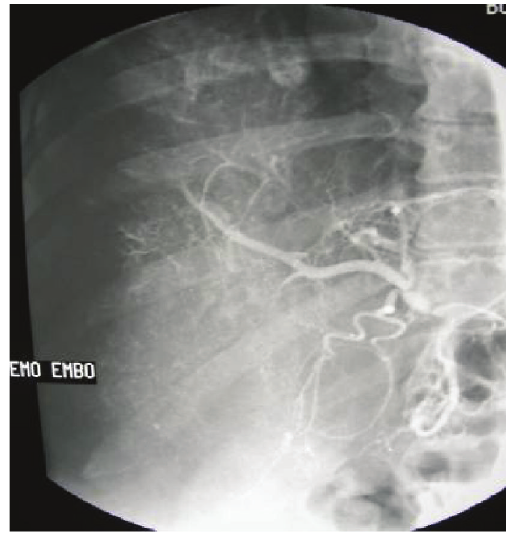
Figure 4: Right hepatic angiogram following chemoembolization of the hepatic angiosarcoma demonstrating the “snow storm” ap- pearance consistent with di ff use uptake and entrapment of the ethiodol within the tumor.